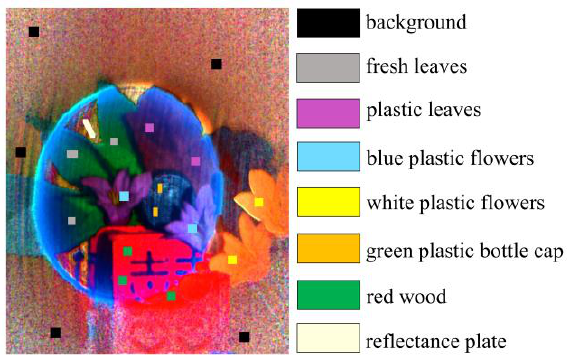
Figure 4. Regions of interest (ROIs) selected for spectral library. Table 1. Pixel numbers of ROIs selected from each object.